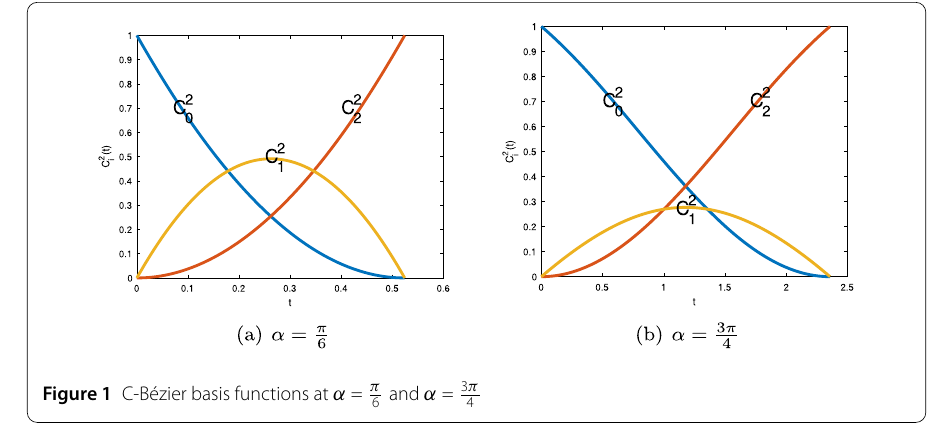
Figure 1 C-Bézier basis functions at α = π